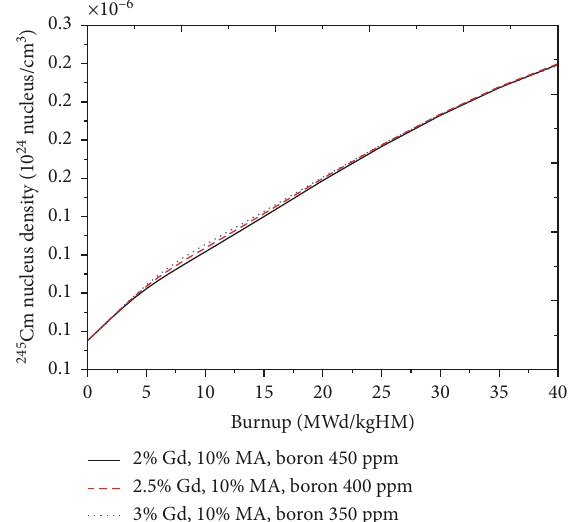
Figure 17: Transmutation of 245 Cm versus burnup when loading 10wt.% of MAs.